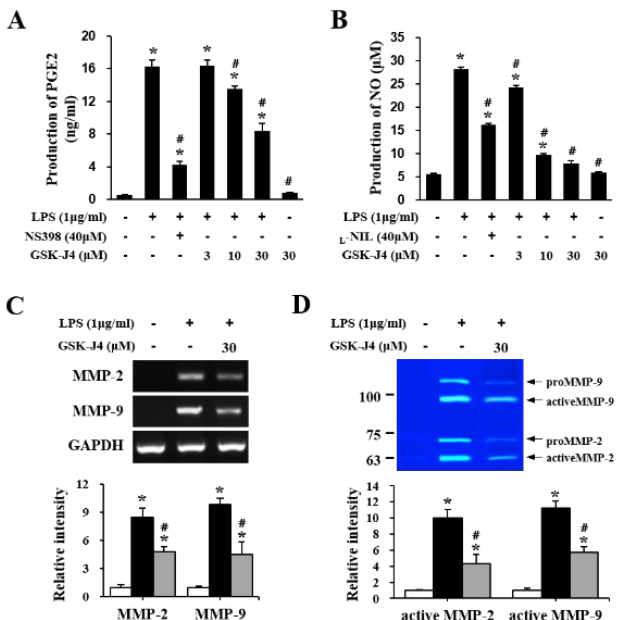
Figure 6. Jmjd3 also regulates macrophage activation in LPS-treated RAW264.7. ( A ) PGE2 production in Raw 264.7 cells by ELISA. Cells were pretreated with different concentrations (3, 10, and 30 µ M) of GSK-J4 for 1 h, and then LPS (1 µ g/mL) was added and incubated for 24 h. (n = 3). ( B ) NO assay in Raw 264.7 cells at 24 h after LPS treatment. (n = 3). ( C ) RT-PCR and quantitative analysis for MMP-2 and MMP-9 at 12 h after LPS treatment (n = 3). ( D ) Gelatin zymography and quantitative analysis for MMP-2 and MMP-9 24 h after LPS treatment (n = 3). N = 3 means the results in each sample were determined in triplicate (technical replicates) on samples deriving from three independent cultures. All data are presented as the mean ± SD. * p < 0.05 vs. Control cells; # p < 0.05 vs. LPS only treated cell.